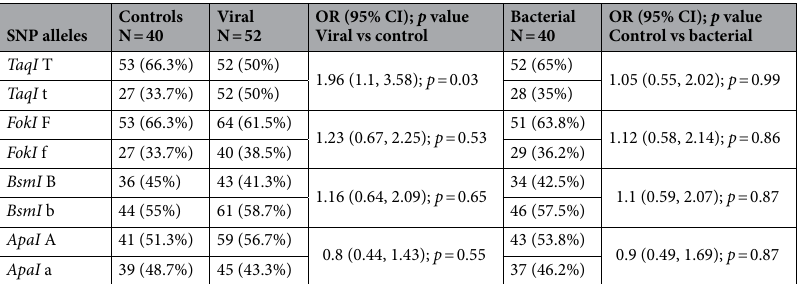
Table 2. Allele frequencies of VDR gene between infants with viral infection compared to controls and between infants with bacterial infection and controls.